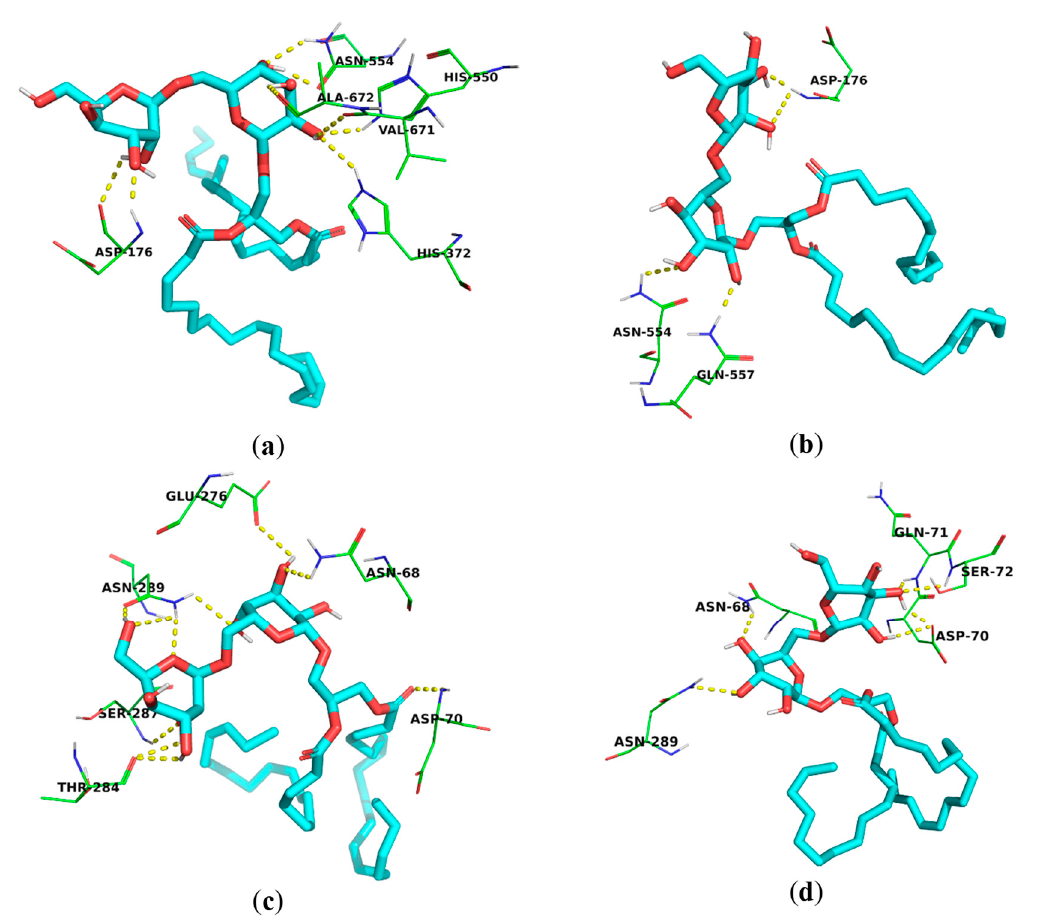
Figure 4. Molecular binding models of the isolated galactolipids within the active sites of the 5-LOX and BchE enzymes obtained using AutoDock Vina ( a ) binding mode of compound 1 within the active site of the 5-LOX enzyme; ( b ) binding mode of compound 2 within the active site of the 5-LOX enzyme; ( c ) binding mode of compound 1 within the active site of the BchE enzyme; ( d ) and binding mode of compound 2 within the active site of the BchE